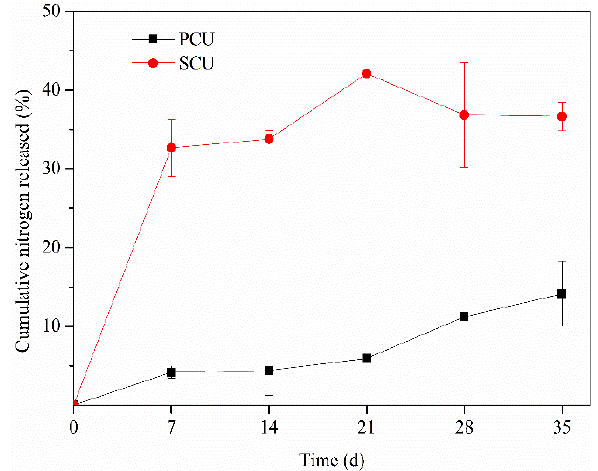
Figure 3. Nitrogen release from polyurethane ‐ coated urea (PCU) and sulfur ‐ coated urea (SCU).